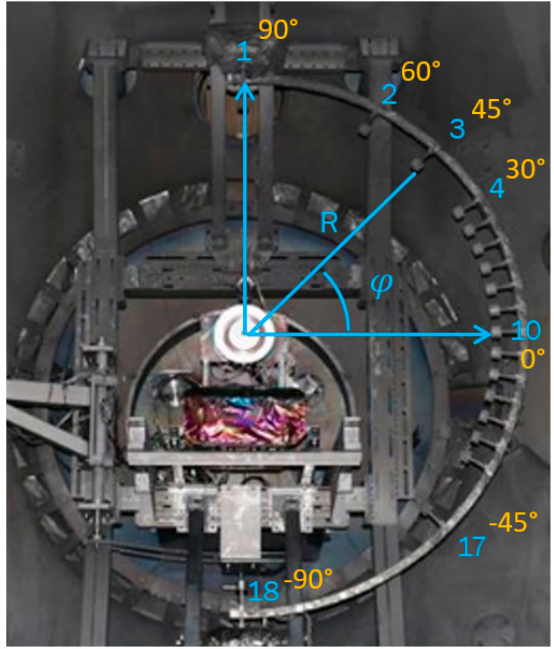
Figure 4. Faraday probes arrangement—the thruster is the HT5k [25].